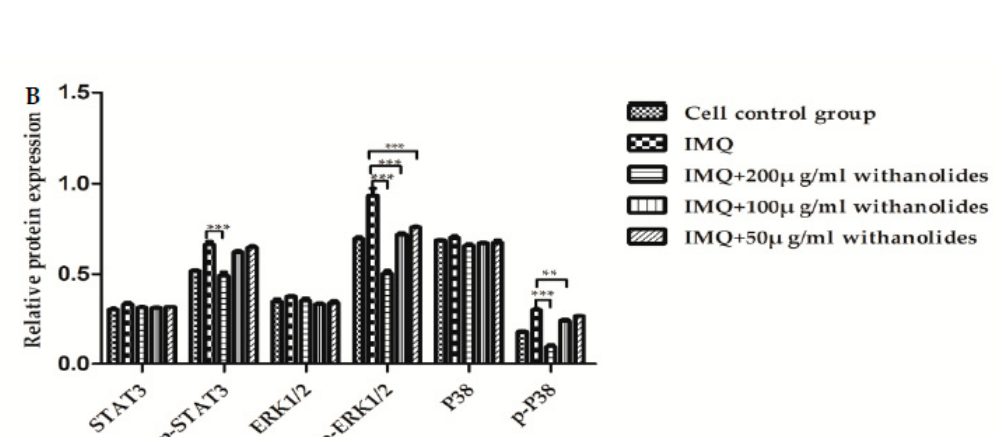
Figure9. E ff ectsofwithanolidesonrelativeproteinexpressionsofsixproteinsinIMQ-stimulatedHaCaT Figure 9. Effects of withanolides on relative protein expressions of six proteins in IMQ- cells ( A ) Representative western blotting of keratinocytes with IMQ stimulation. ( B ) Representative stimulated HaCaT cells ( A ) Representative western blotting of keratinocytes with IMQ protein levels in HaCaT cells. ** p < 0.01 *** p < 0.001 vs. IMQ stimulation. ( B ) Representative protein levels in HaCaT cells. ** p < 0.01 *** p < 0.001 vs. IMQ group.